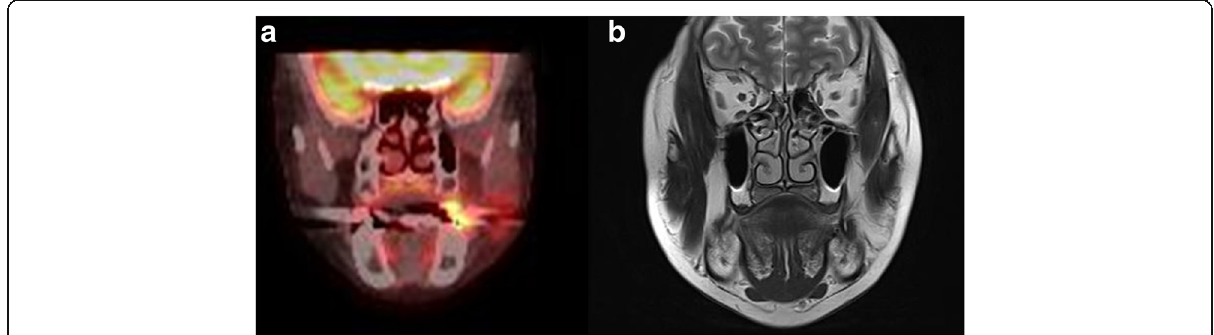
Fig. 4 Radiological findings showing post-op state change on left buccal area. a 18-FDG PET/CT coronal view showing hot FDG spot on left buccal area because of post-operative change. b T2-weighted magnetic resonance image, coronal